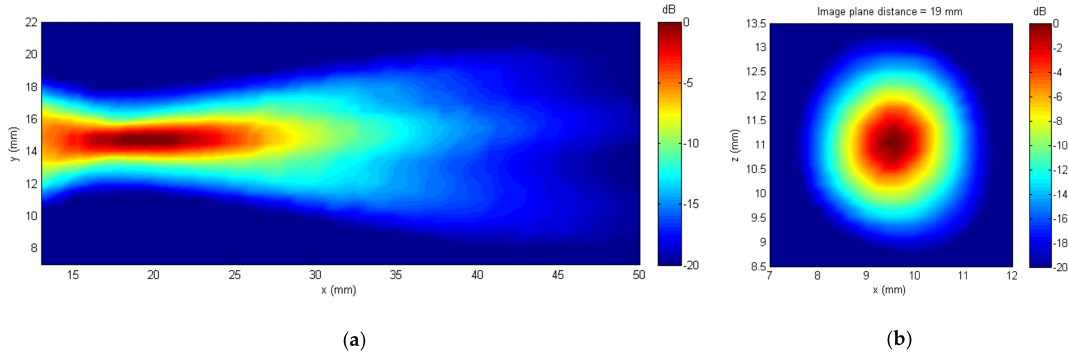
Figure 13. HS03 spherically focused transducer (radius of curvature 22 mm) acoustic field. ( a ) axial section, ( b ) transversal